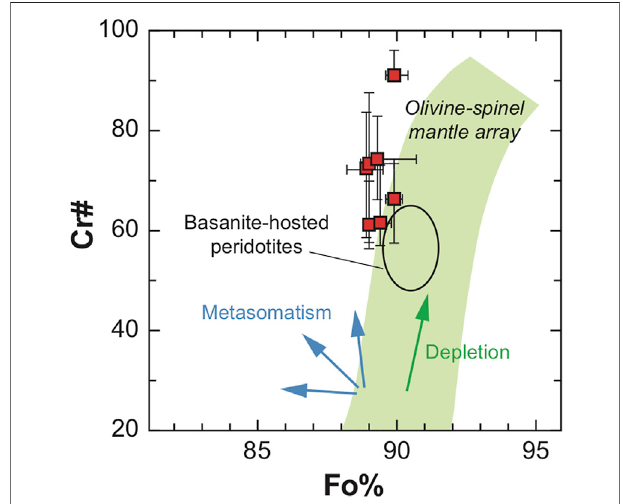
FIGURE10| CompositionalrelationshipbetweenFo%ofolivineandCr# of coexisting spinel in the investigated peridotite xenoliths from La Palma, as compared to the mantle array after Arai (1994). Symbols indicate the average values for the interior parts of each sample; error bars encompass minimum and maximum values. Field for basanite-hosted peridotites based on data from Wulff-Pedersen et al. (1996) and Klügel